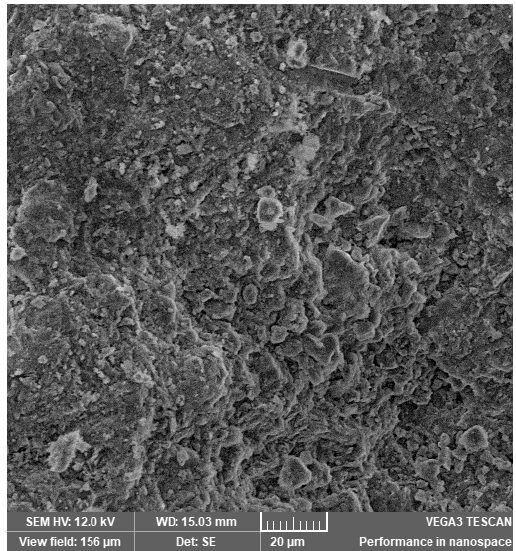
Figure 8. The SEM analysis of the zeolite sample HCl 1.